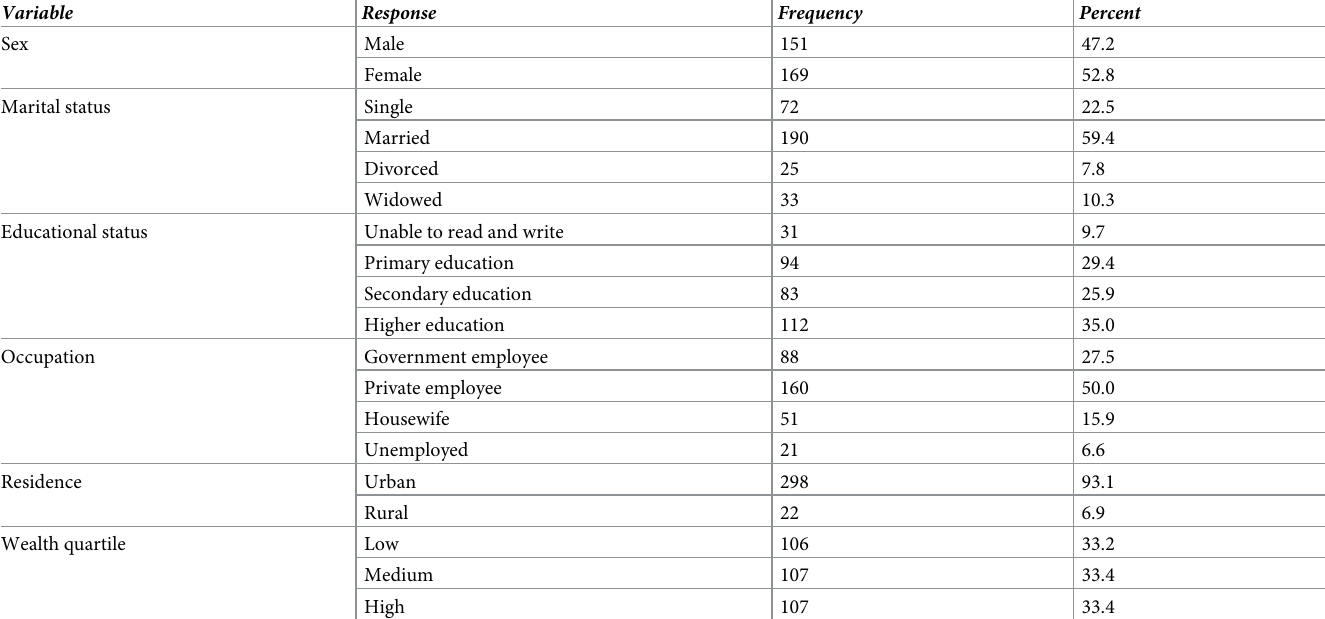
Table 1. Socio-demographic characteristics of study